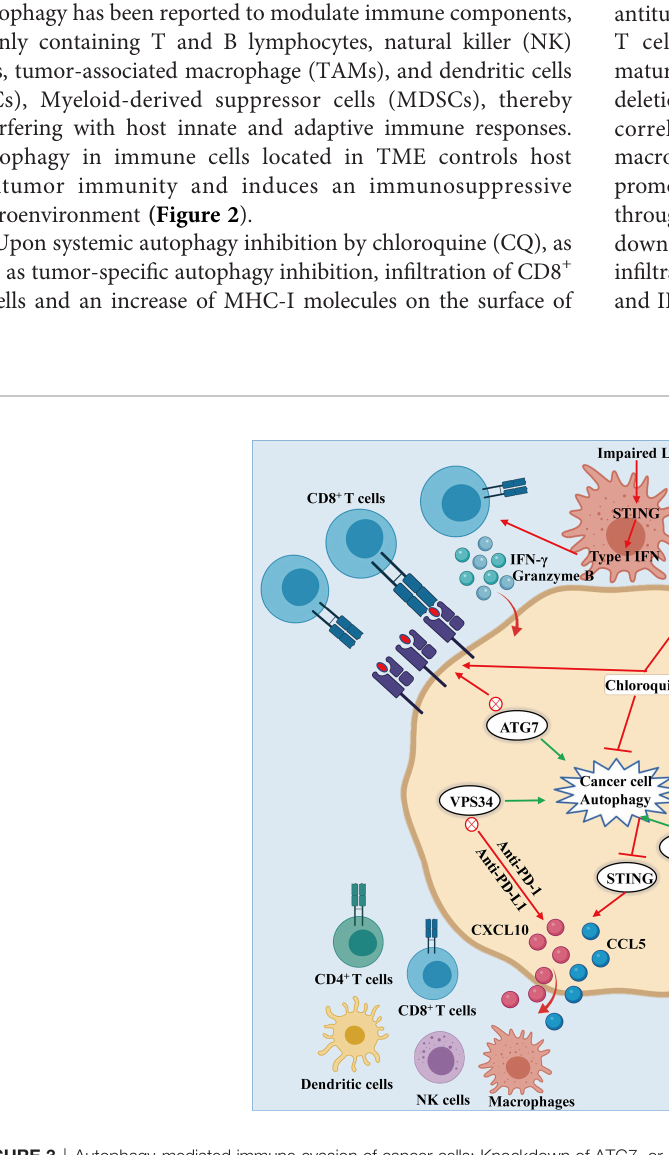
FIGURE 3 | Autophagy-mediated immune evasion of cancer cells: Knockdown of ATG7, or dominant negative expression of ATG4B or treatment of chloroquine leads to the inhibition of autophagy, which induces the accumulation of MHC-I on the surface of cancer cell. The MHC-I accumulation promotes the recognition and effect of CD8 + T cells on cancer cells. Likewise, inhibiting autophagy results in the in fi ltration of TAMs and the conversion of macrophages from M2 to M1 phenotype, thereby enhancing the antitumor activity. What is noteworthy is that impairment of LAP results in activation of T cells mediated by STING, producing granzyme B and IFN- g to kill the cancer cells. In addition, the combination of PIK3C3/VPS34 inhibitors with anti-PD-1 and PD-L1 therapy could increase the numbers of NK and CD8 + , CD4 + T cells, macrophages and dendritic cells along with CCL5 and CXCL10 in fi ltrating in tumor environment. Moreover, SKIL promoted tumorigenesis and immune escape of NSCLC cells by up-regulating the TAZ/autophagy axis and inhibition on downstream STING pathway, thereby resulting in reducing T cell in fi ltration and release of chemokines including CXCL10, CCL5 and IFN- b